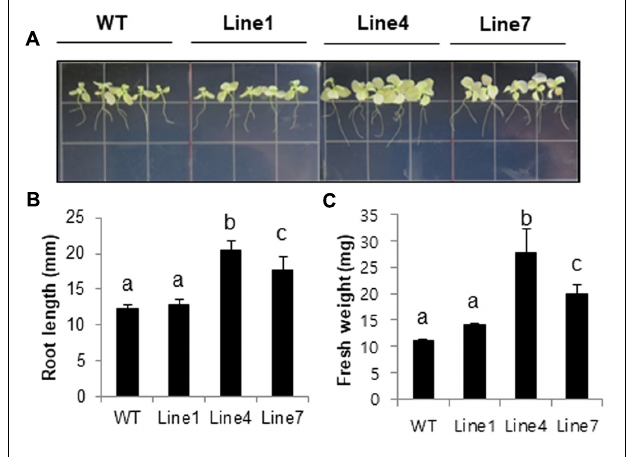
FIGURE 2 | Effects of sysr1 overexpression on salt tolerance during the seedling stage. (A–C) Phenotypes of WT and transgenic plants grown on Murashige and Skoog medium supplemented with 300 mM NaCl. Two-week-old WT and transgenic plants (Lines 1, 4, and 7) grown on Murashige and Skoog agar were transferred to the same medium containing 300 mM NaCl, and plants were allowed to grow for an additional 4 weeks. Plants were photographed at the conclusion of the salt treatment. (B) Analysis of root length and (C) whole-seedling fresh weight. The data for three biological replicates were averaged. Different letters represent significant differences at P < 0.05 ( t -test). Bars indicate the standard deviation of the mean.